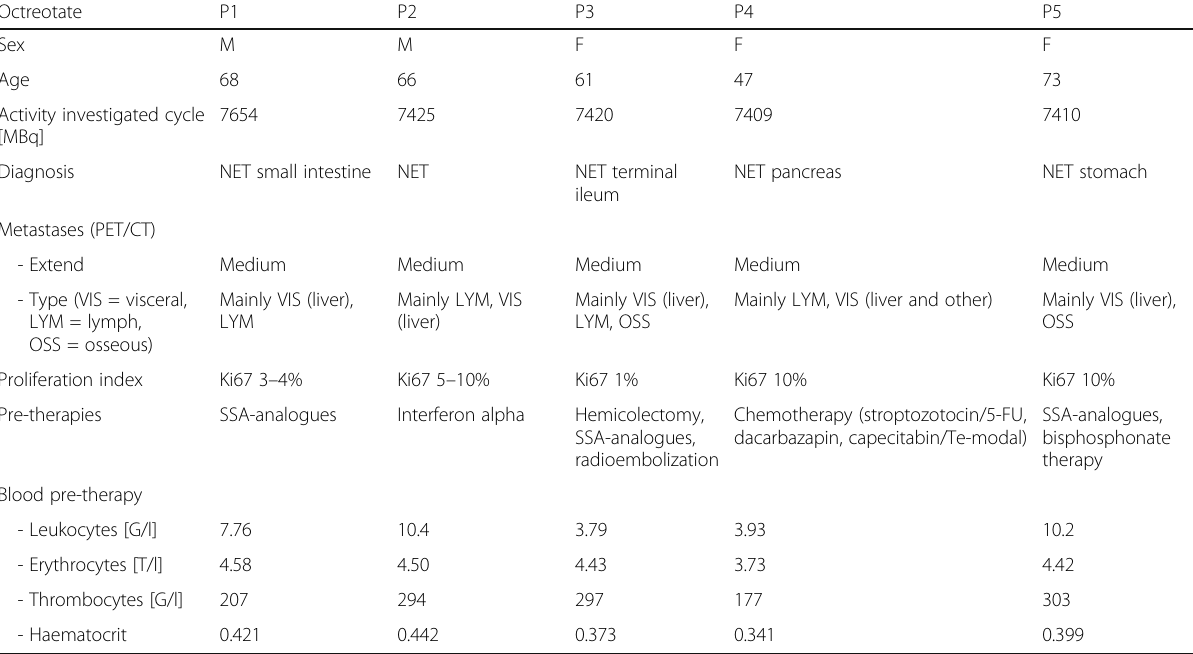
Table 1 Characteristics of all NET patients included in this study for Lu-177-Octreotate therapy Octreotate